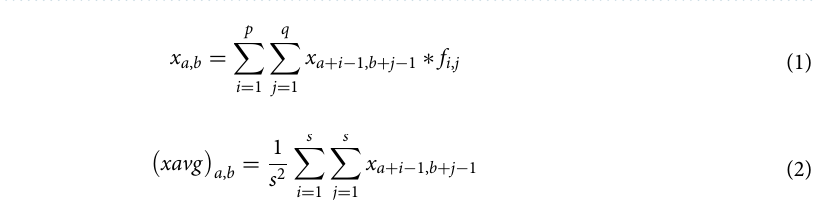
Figure 4. ( a ) The proposed IoT malware detection architecture ( b ) STM block ( c ) details of blocks used in the